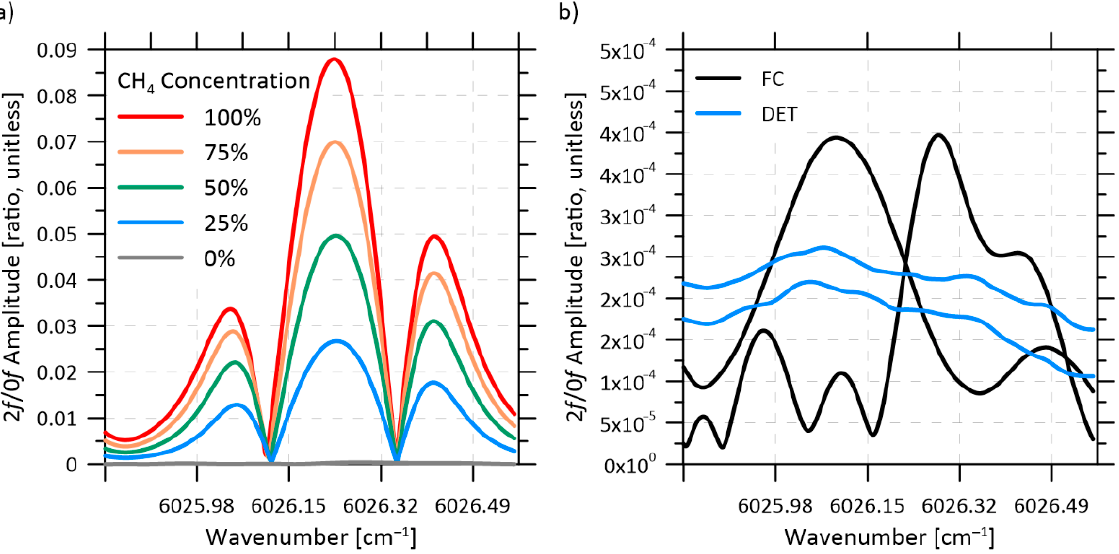
Figure 7. ( a ) 0 f normalized 2 f signals (2 f /0 f ) over a range of methane volume fractions, using the FC configuration. ( b ) Background 2 f /0 f signals when the measurement cell was filled with nitrogen, for both the FC (black) and DET (blue) configurations. Both subplots only show the first half of the triangular sweep period.